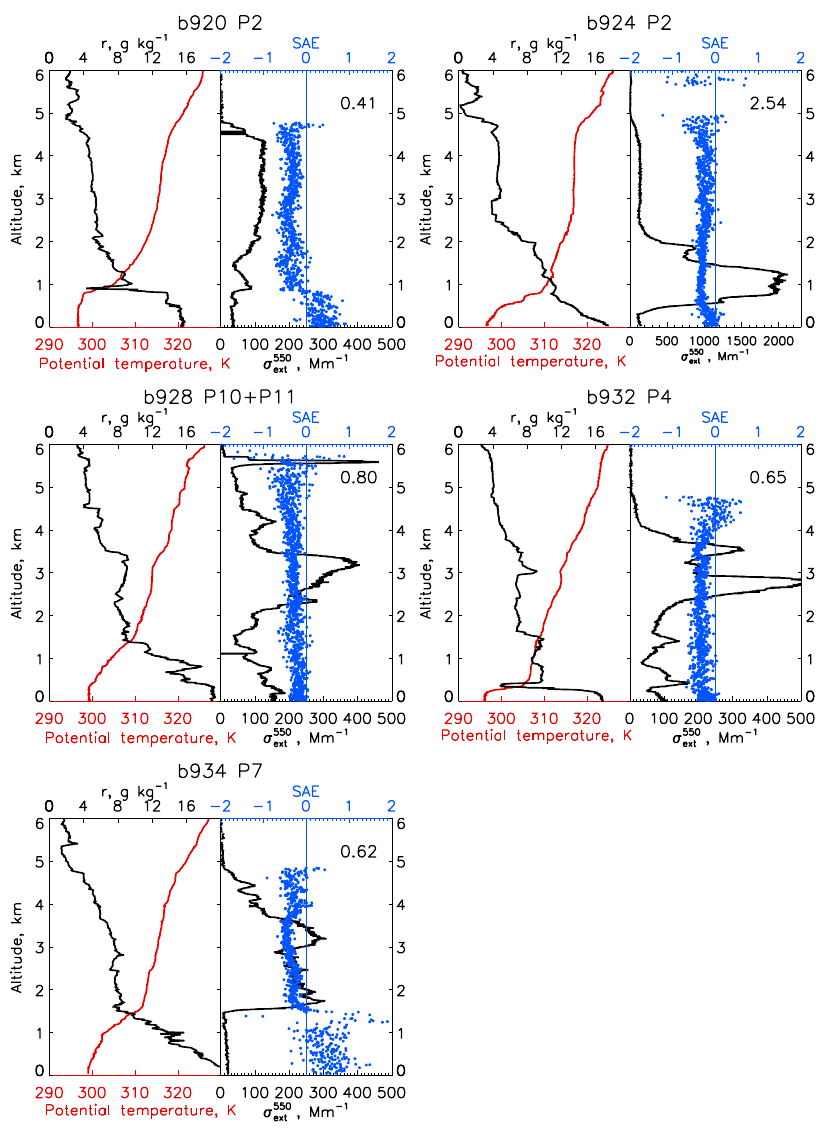
Figure 4. Vertical structure observed during the five flights from in situ measurements during aircraft profiles, in the region where the SLRs were performed. Potential temperature (K; red), water vapour mixing ratio ( r , gkg − 1 , black), accumulation mode extinction (Mm − 1 , black; note different x -axis range for b924) and SAE for the accumulation mode between 450 and 700nm (blue). Numbers at the top right of each panel indicate accumulation mode AOD at